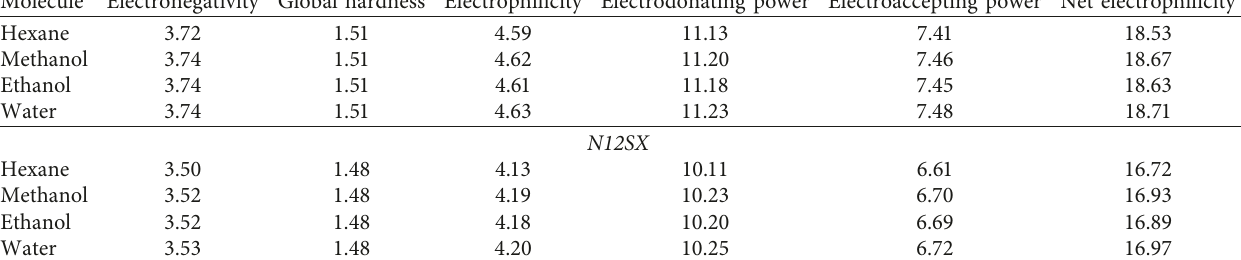
Table 9: Global reactivity descriptors for the myxol pigment calculated with the MN12SX and N12SX density functionals and the Def2TZVP basis set using the four solvents, simulated with the SMD parametrization of the IEF-PCM model.